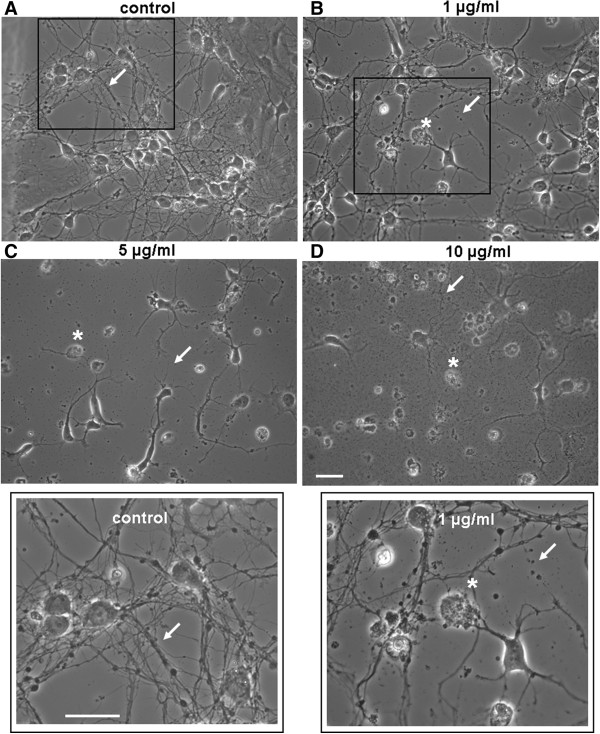
Exposure to AgNPs compromises neuronal viability and perturbs neurite outgrowth. Phase contrast images of rat cortical neurons cultured either in the absence (A, control) or presence of various concentrations of AgNPs at 1 (B), 5 (C), and 10 (D) μg/ml for 3 days. (A) Shows the control group grown in the absence of AgNPs is characterized by healthy cell bodies and well-established neuronal processes (indicated by an arrow, also see insert). (B) Shows that AgNPs at the concentration of 1 μg/mL caused cell damage (indicated by an asterisk) and triggered fragmentation of developing neuronal networks (indicated by an arrow) (also see insert). (C) Indicates that cells cultured in AgNPs at 5 μg/mL have an increased number of deteriorating cells (indicated by an asterisk) and a markedly reduced degree of neurite outgrowth (indicated by an arrow). (D) In the presence of AgNPs at 10 μg/mL, the majority of cells underwent cell death and abnormal/limited neuronal sprouting and outgrowth. Arrows indicate neuronal processes and asterisks indicate neuronal cell bodies. Scale bar, 25 μm.